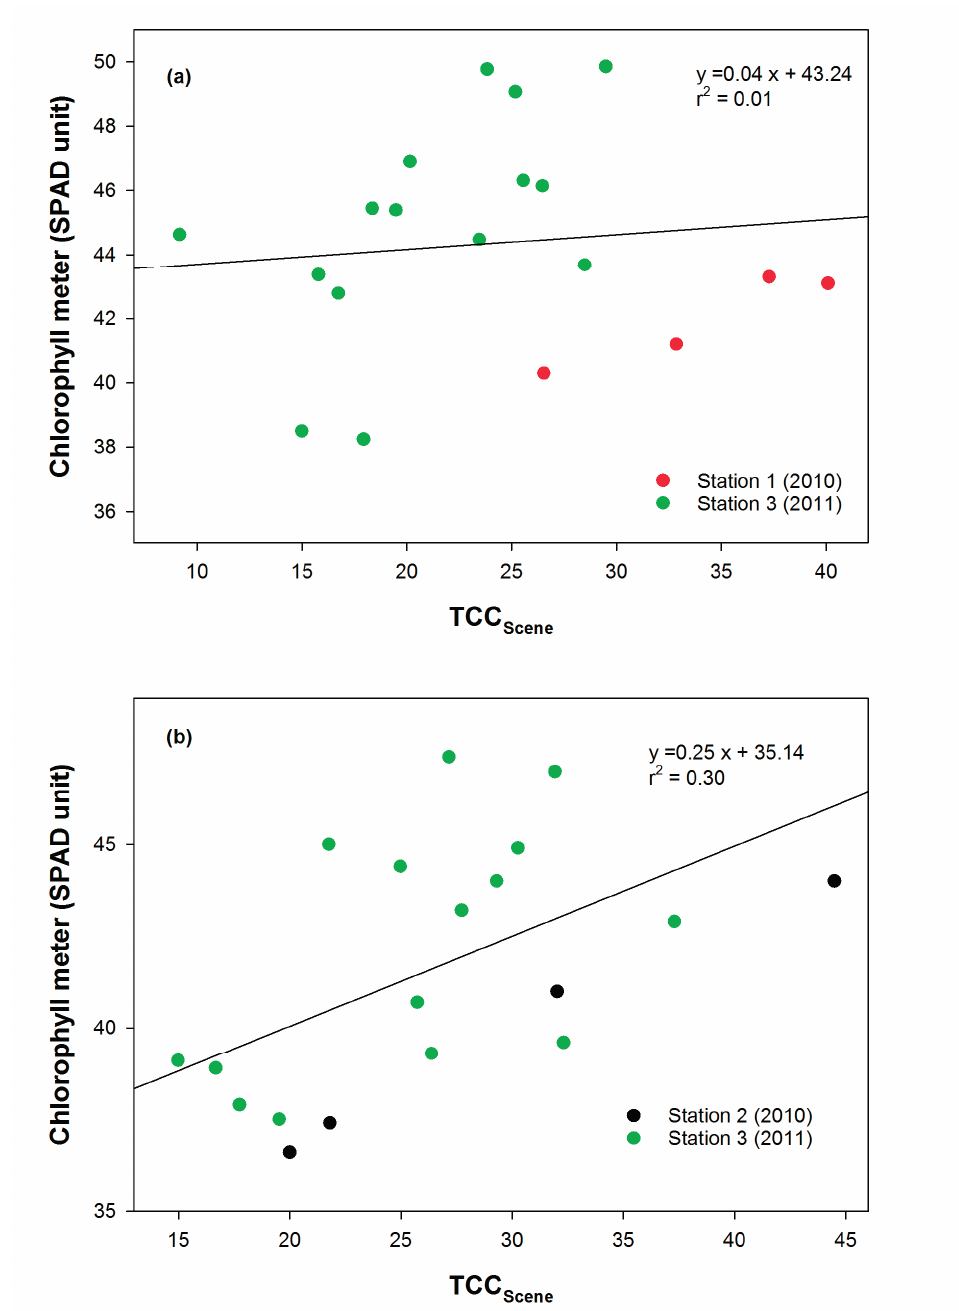
Figure 8. Linear regression between TCC Scene and chlorophyll meter readings at ( a ) mid to late squaring, and ( b ) early